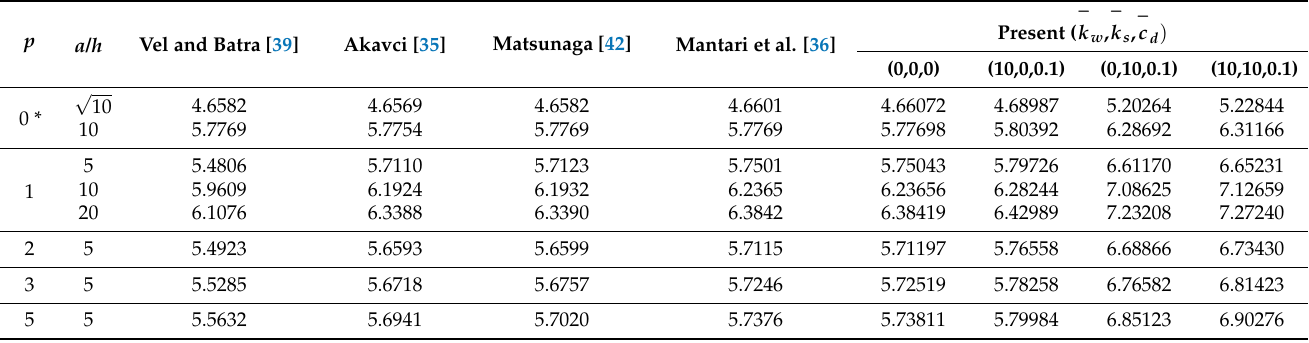
Table 7. Non-dimensional fundamental frequencies ˇ ω = plates on Visco-Winkler-Pasternak